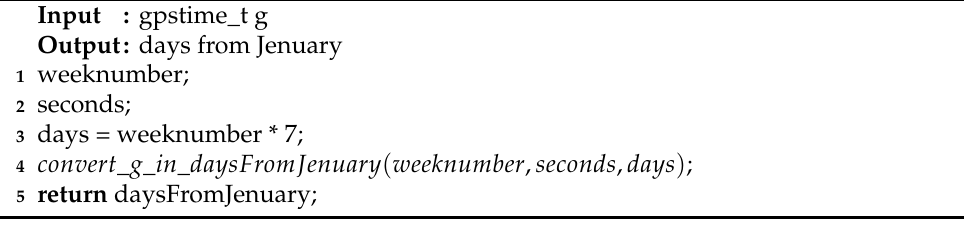
Algorithm 3: parameterTropos: Calculate the parameter ξ as function of φ and D